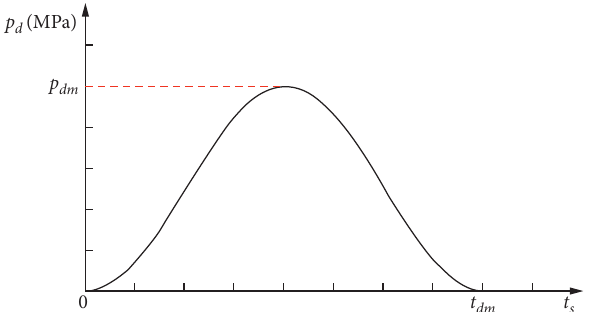
Figure 5: The waveform of dynamic stress p p dm and duration of t dm .